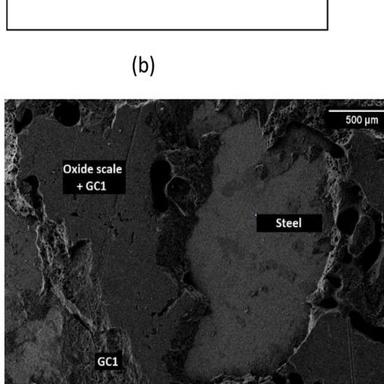
(a) fracture surfaces after torsion for a THG-5 sample joined by GC 1 and tested at 600 °C, showing mixed (i.e. adhesive/cohesive) behavior as sketched in (b), with GC1 being present on both fracture surfaces, as observed by SEM-EDS (c), with each region identified.